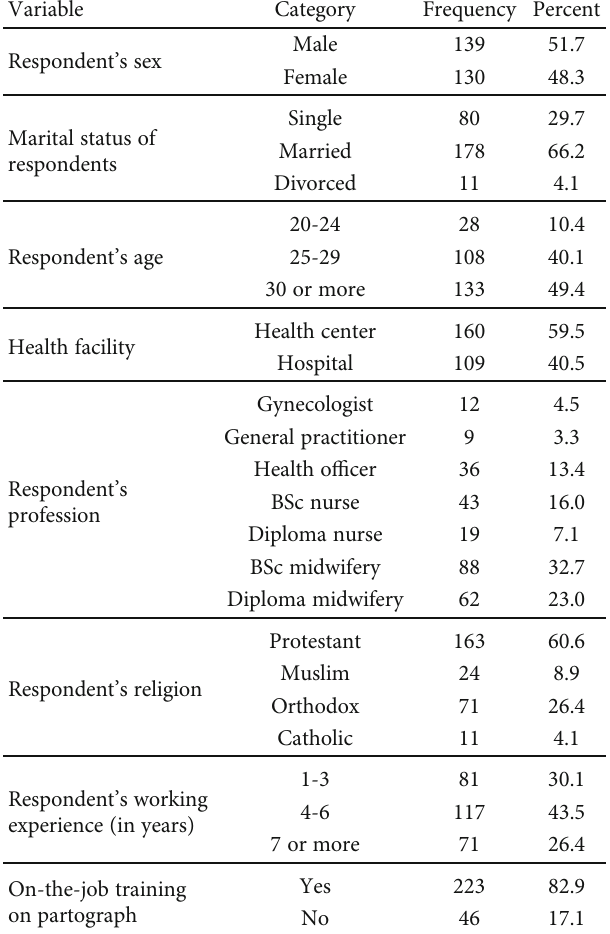
Table 1: Sociodemographic characteristics of obstetric caregivers in Wolaita Zone, SNNPR, Ethiopia, 2017 ( N = 269 ).